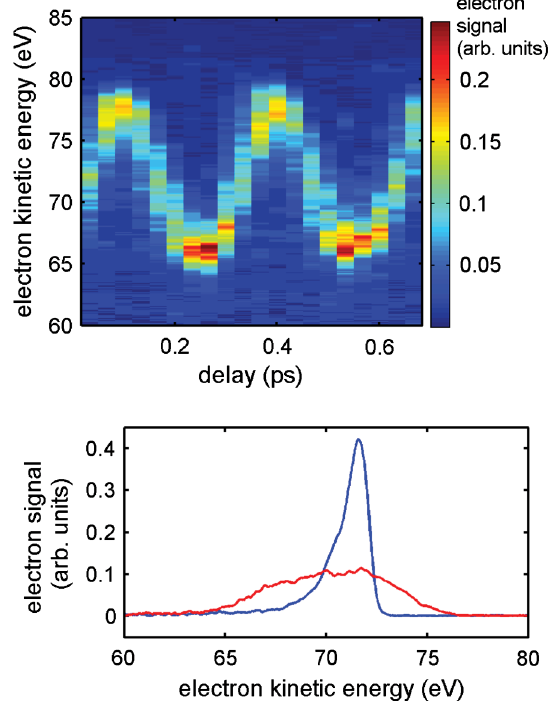
FIG. 11. Series of photoelectron spectra measured for different terahertz-XUV delays (upper panel). The energy shift of the electrons versus the x-ray/terahertz delay directly represents the vector potential of the terahertz field. Each spectrum was averaged over 20 shots. The lower panel shows the nonstreaked (blue line) and streaked (red line) photoelectron spectrum measured parallel to the terahertz polarization. The delay was set to a zero crossing of the terahertz vector potential ( ∼ 0 . 35 ps in the upper panel). Each spectrum was averaged over 500